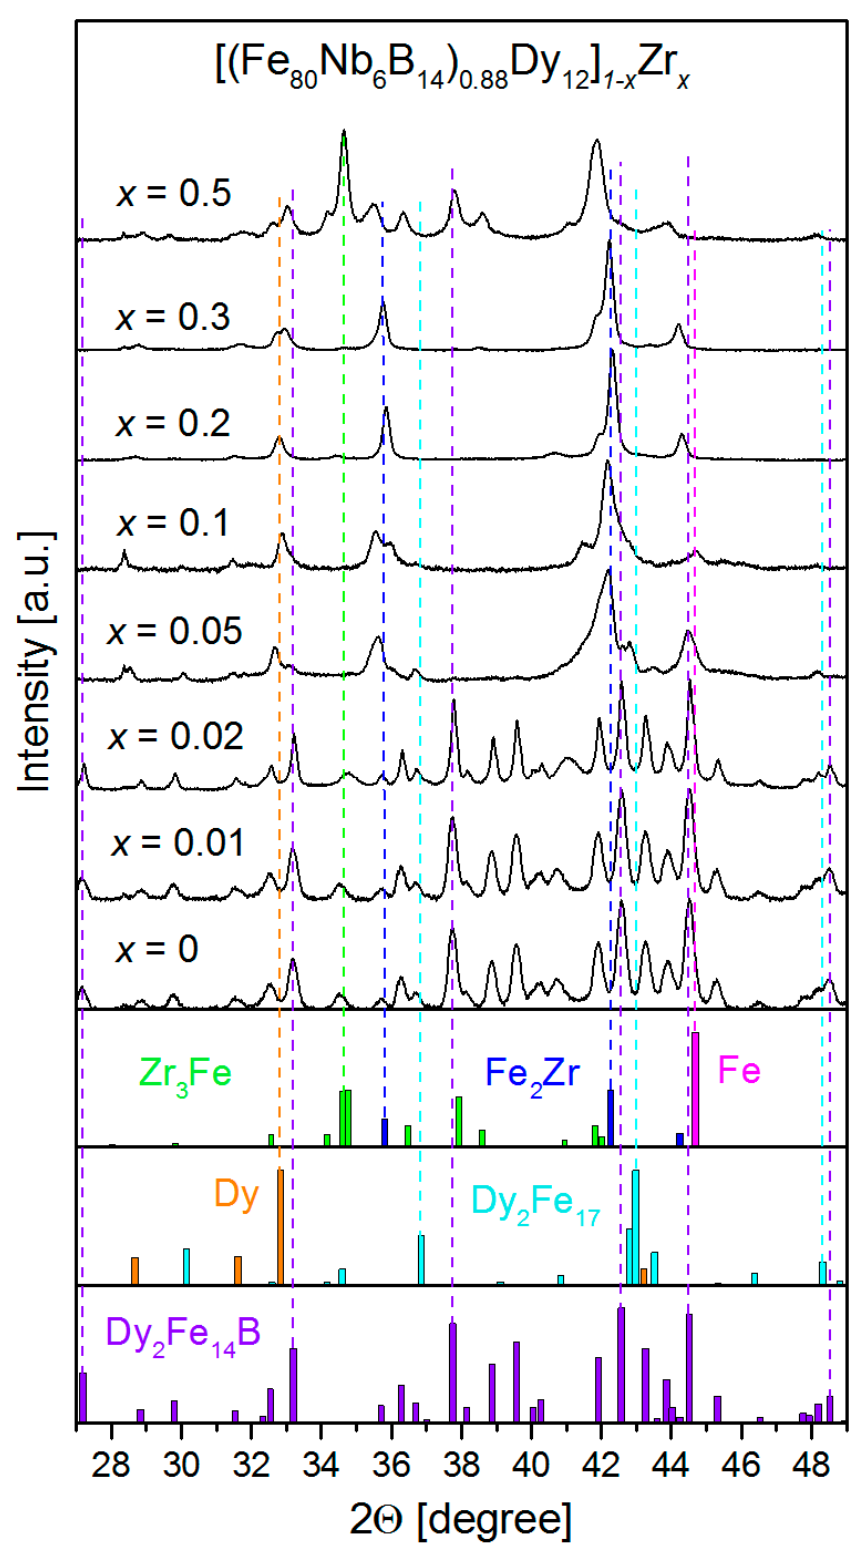
Figure 1. XRD patterns for all studied alloys and selected reference patterns for detected magnetic phases. Table 1. Contributions of these phases (at.%) in [(Fe 80 Nb 6 B 14 ) 0.88 Dy 0.12 ] 1 − x Zr x determined from the XRD analysis. The estimated error of the phase content is about 2%.